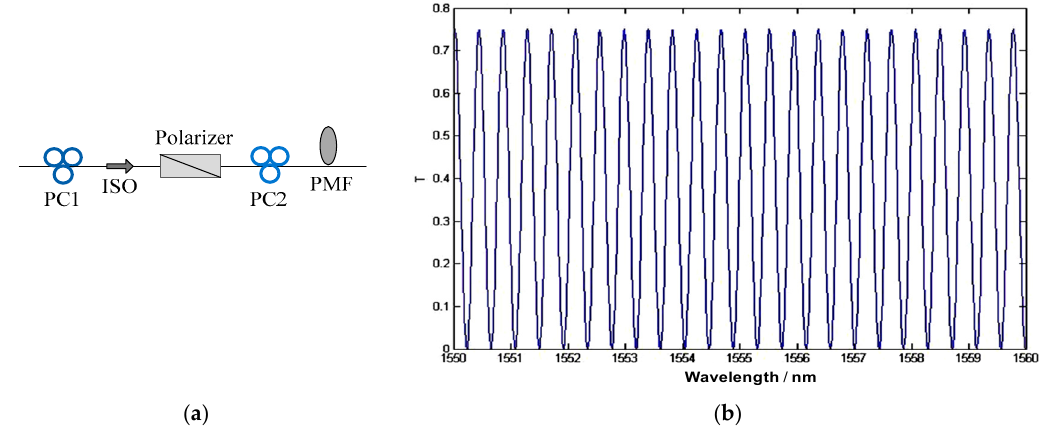
Figure 2. ( a ) The formed Lyot filter and ( b ) its calculated transmission spectrum (PC1/PC2: polarization controller, PMF: polarization-maintenance fiber, T: normalized transmission).